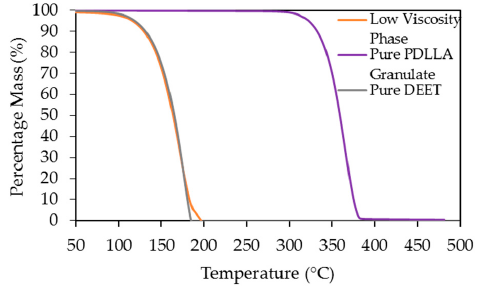
Figure 2. Thermogravimetric analysis (TGA) curves of pure PDLLA, pure DEET and the low viscosity phase separated at 21 °C.